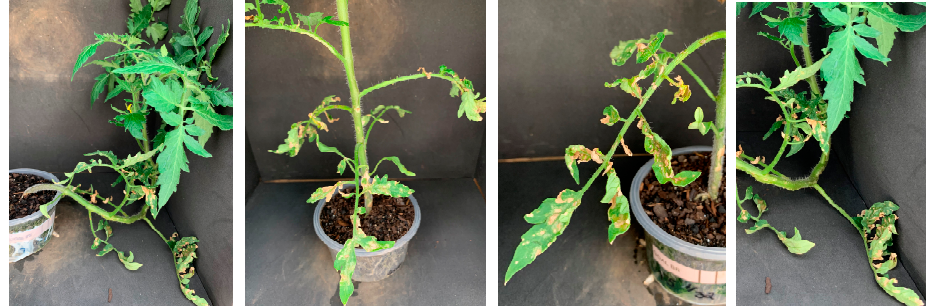
Figure 10. The e ff ects of simulated oxy fl uorfen drift with a close-up view show injuries in tomato plants. 3.4. E ff ects of Simulated Drift Caused by PSII-Inhibiting Herbicides The simulated drift of hexazinone and diuron in tomatoes causes similar symptoms characterized by chlorosis on leaf edges that progresses to the leaf center (Figures 11–14). Symptoms started appearing on the third day after exposure to the simulated herbicide drift in all applied dose ratios. The symptom was milder in the lowest simulated drift of 1/64.